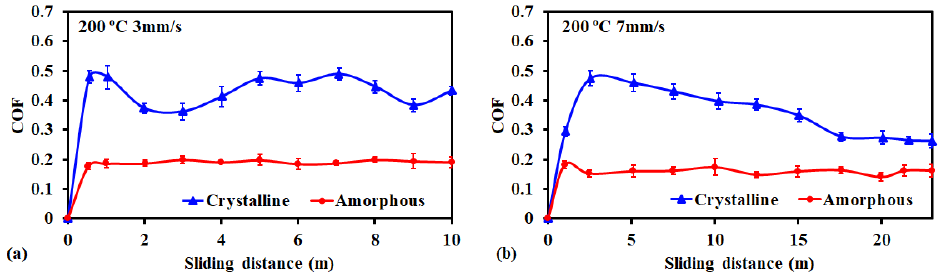
Figure 10. The measured coefficient of friction (COF) for crystalline Pd and amorphous Pd alloy samples with respect to sliding distance with the ionic liquid at 200 °C: ( a ) Sliding speed of 3 mm/s, ( b ) sliding speed of 7 mm/s.